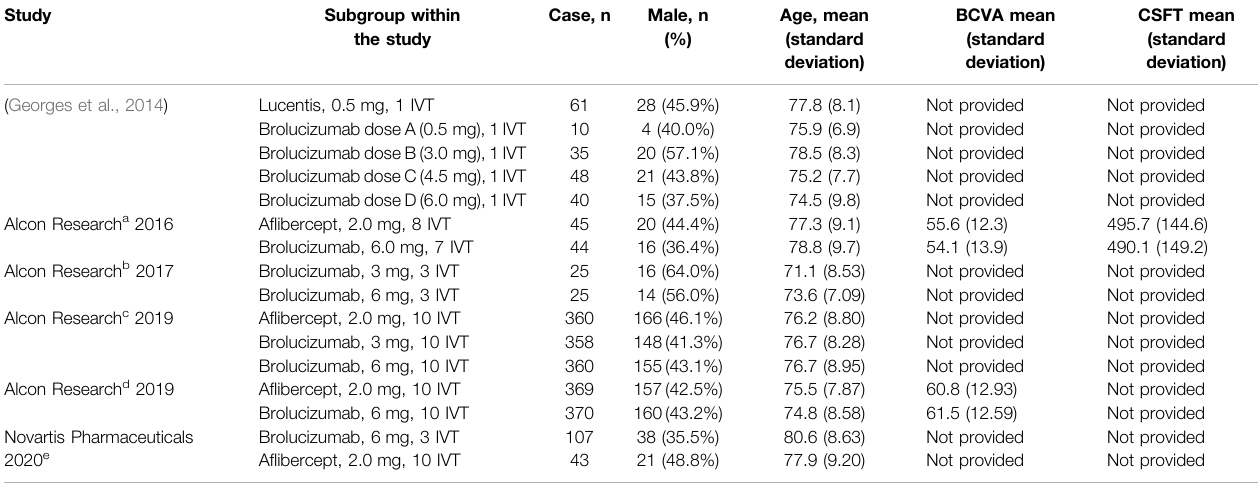
TABLE 2 | Baseline characteristics of subjects of six